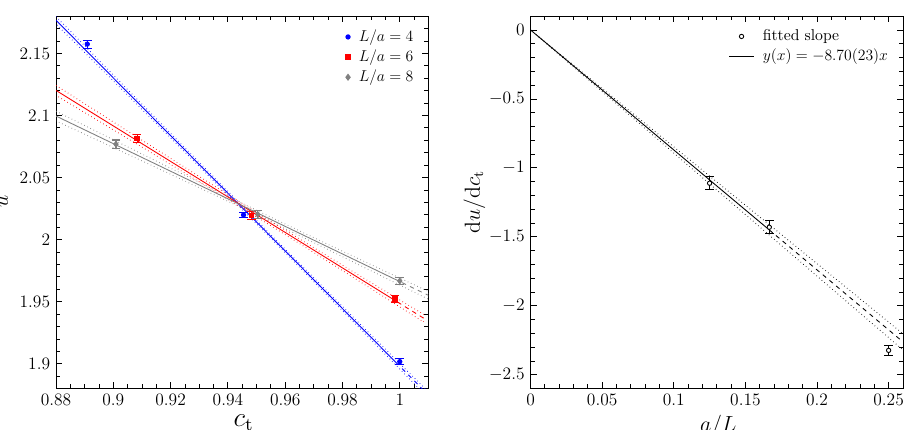
Fig. 8 The left panel shows the dependence on c t of the coupling u = ¯ g 2 ( L ) . The improvement coefficient is varied around its 2-loop value and the value of the coupling is u ≈ 2. The right panel shows the slopes vs. a / L